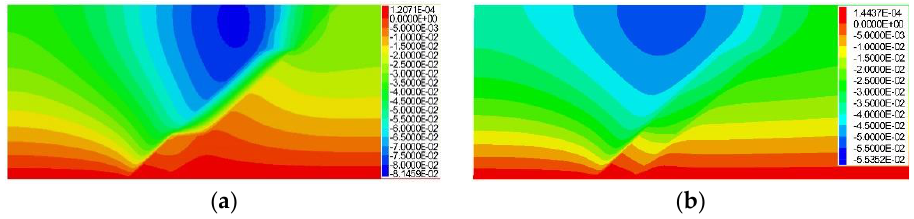
Figure 13. Cloud diagram of vertical displacement of overlying rock of different backfilling bodies. ( a ) Full tailings cemented backfilling and ( b ) Medium and fine tailings paste backfilling. Through the analysis of the experimental data, the roof subsidence curves of different filling bodies are obtained. The results are shown in Figure 14.